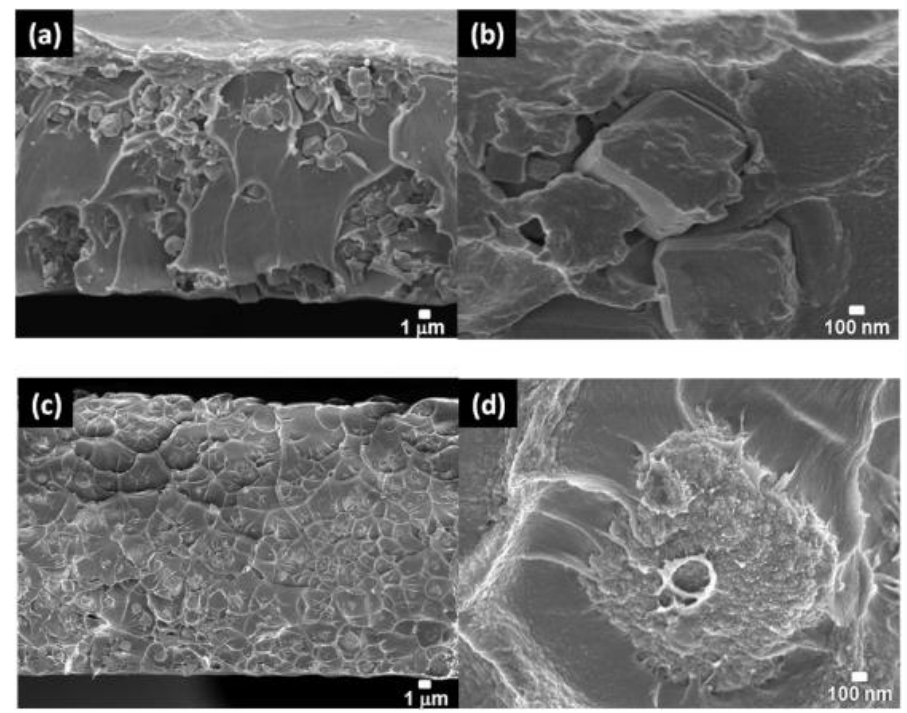
Figure 9. Cross section FESEM images of mixed-matrix membranes: ( a , b ) Matrimid with embedded pristine zeolite 5A; and, ( c , d ) Matrimid with embedded surface modified zeolite 5A [155], with copyright permission from © 2016 Elsevier. Table 7. Gas separation performance of zeolites-based mixed matrix membranes (operating conditions ranging within 1–5 bar, 20–35 °C, unless differently specified).